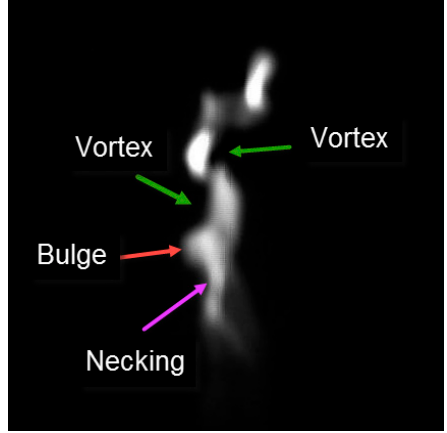
Figure 2. The appearance of flame flicker.